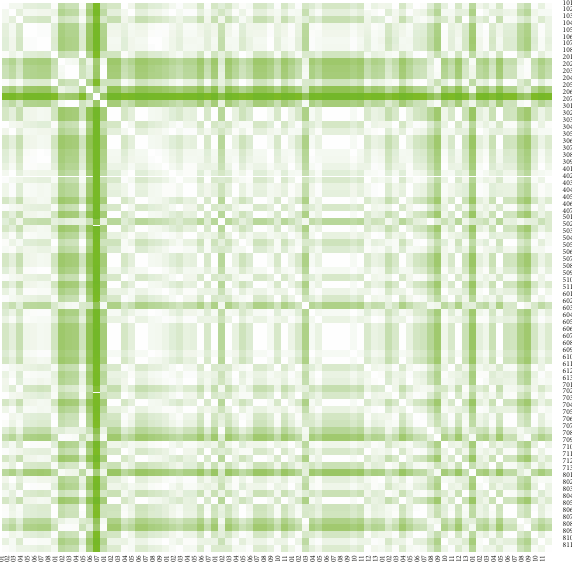
Figure 17: The distance matrix of the similarity of the districts for the female sex in 2015.